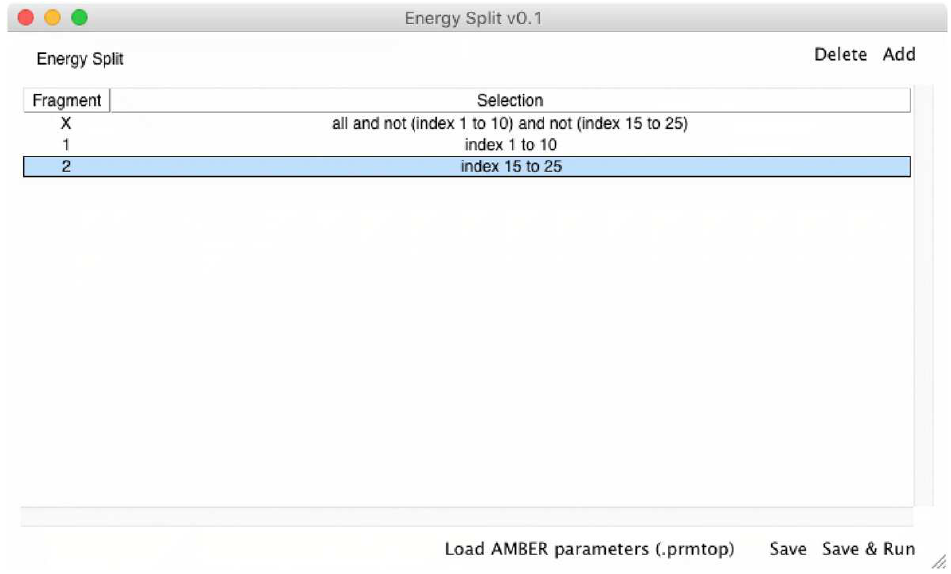
Figure 4. Screen shot of the Energy Split extension for VMD showing a system split into three